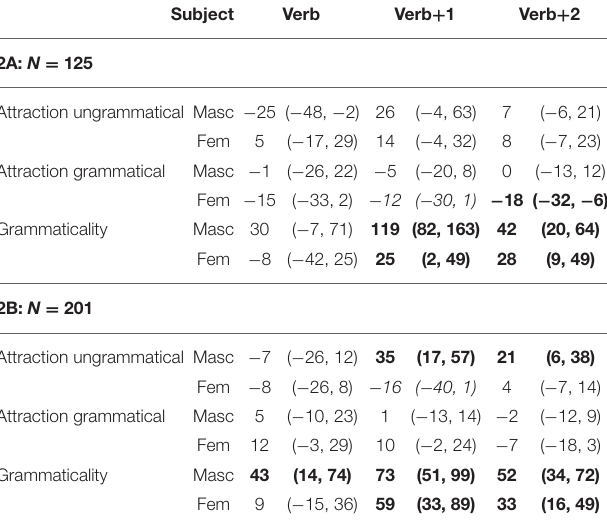
Table 4 | Results of experiment